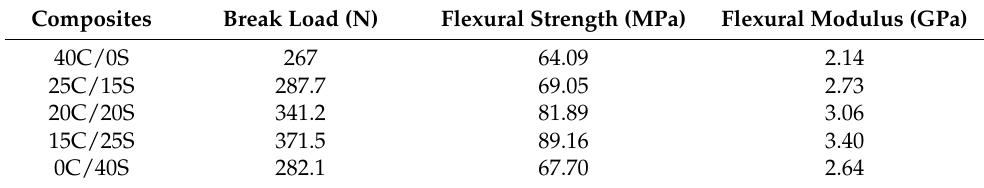
Table 5. Flexural strength